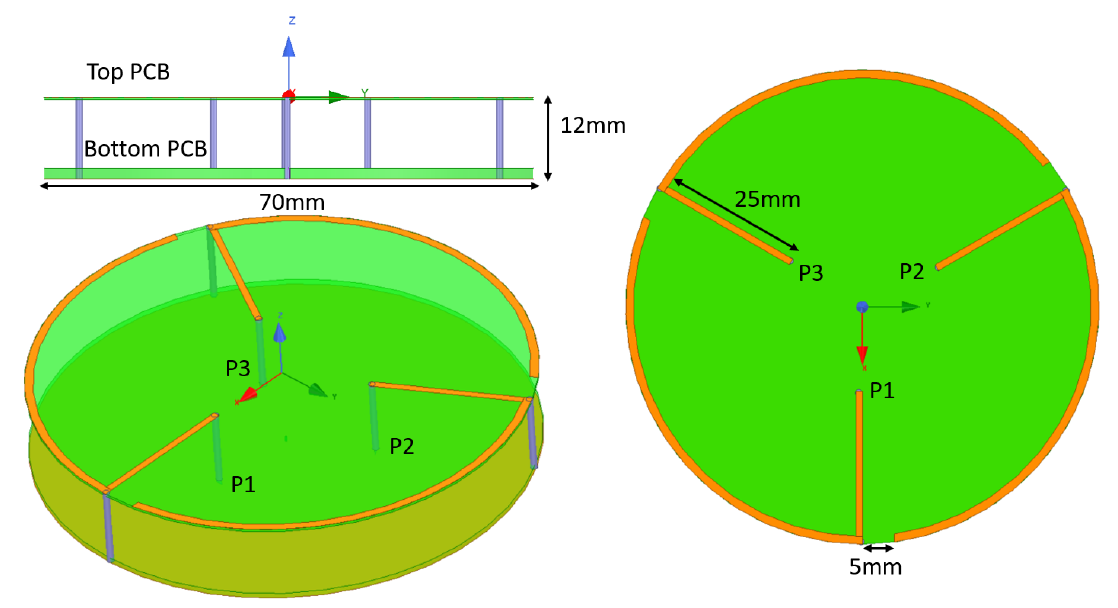
Figure 1. Top, side, and 3D view of the radiating structure.